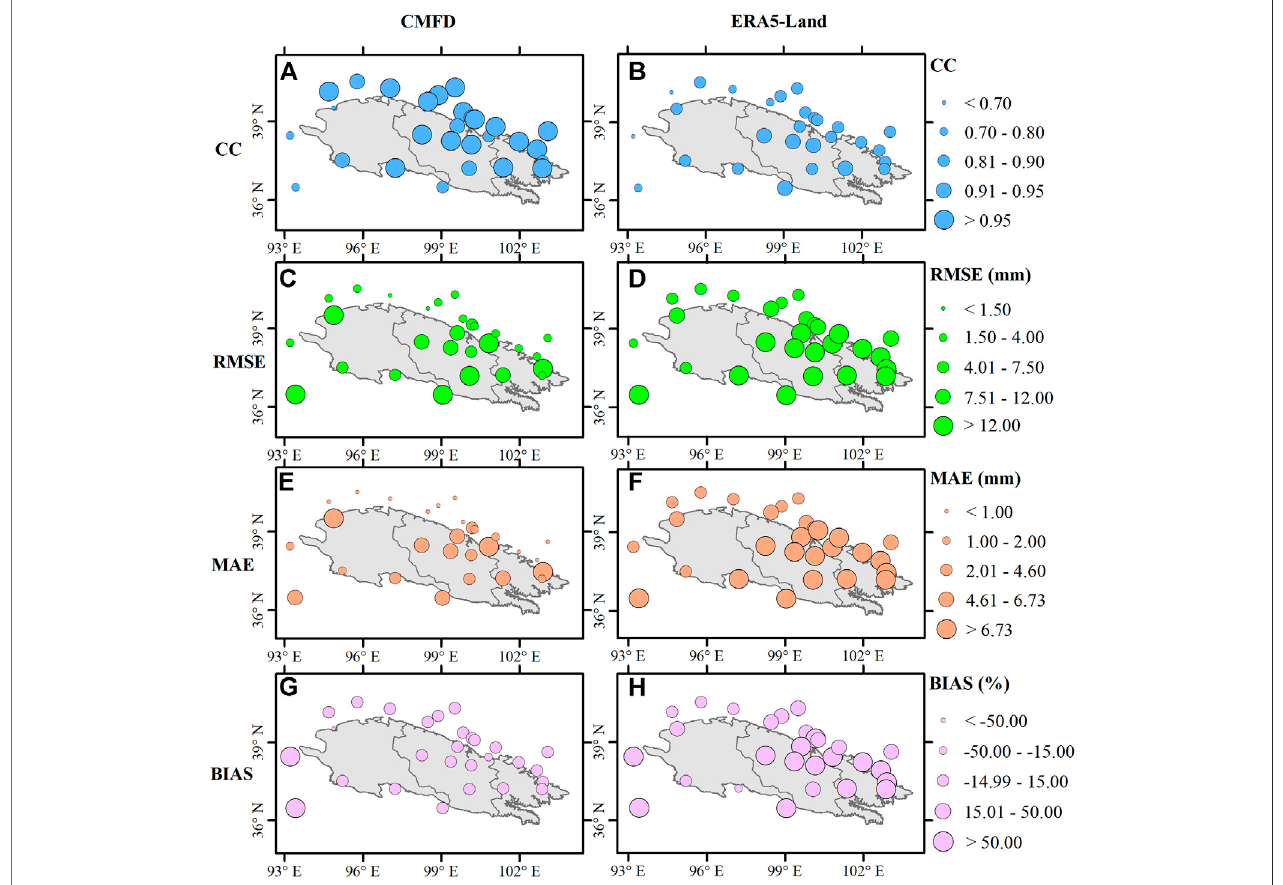
FIGURE 4 | Correlation coef fi cients (CC) (A,B) , root mean square error (RMSE) (C,D) , mean absolute error (MAE) (E,F) , and mean bias (BIAS) (G,H) of monthly precipitation in the two reanalysis datasets, relative to monthly mean precipitation observations.